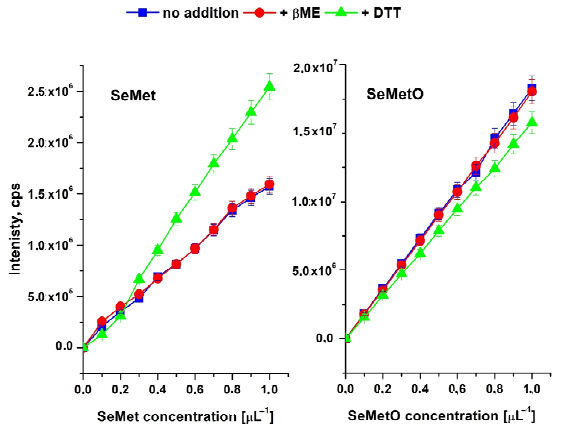
Table 2. Parameters of the calibration equations and validation parameters in ZIC-HILIC separation using methanol/water eluent (85/15, v / v ). Analyte Abbreviation